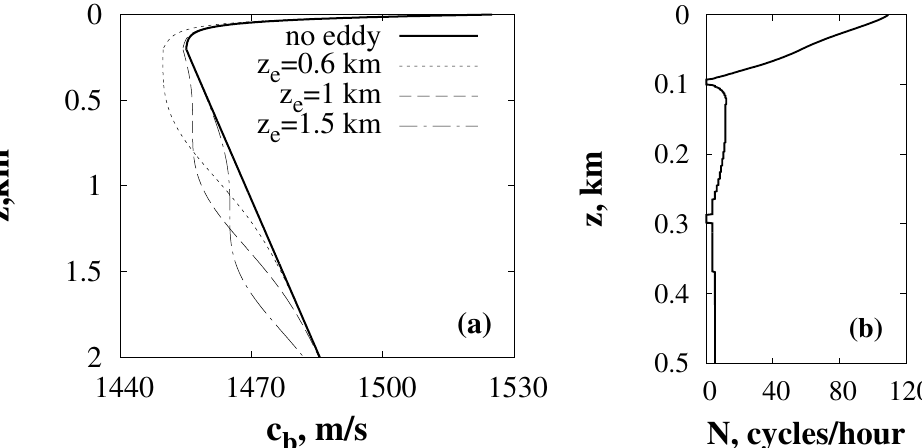
Figure 1. ( a ) Background sound-speed profile and sound-speed profiles including eddy-induced perturbation. ( b ) Profile of the Väisäla–Brunt frequency in the upper oceanic